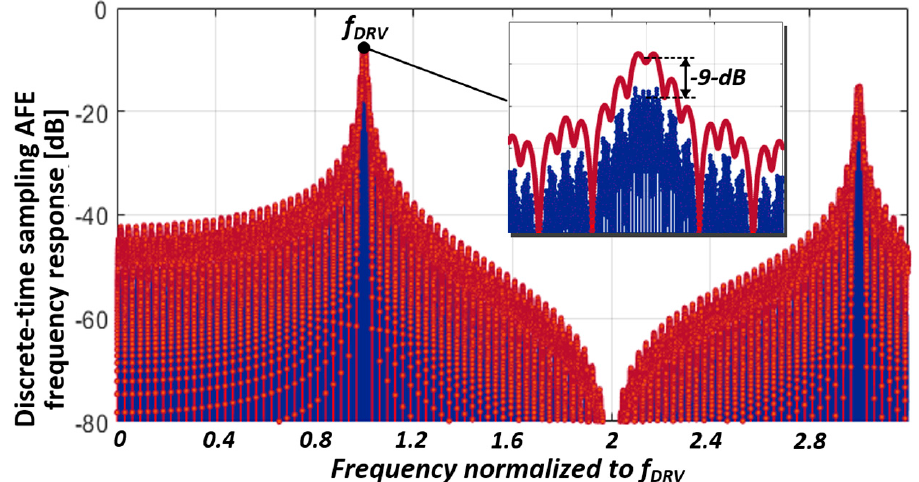
transfer function for C ref .